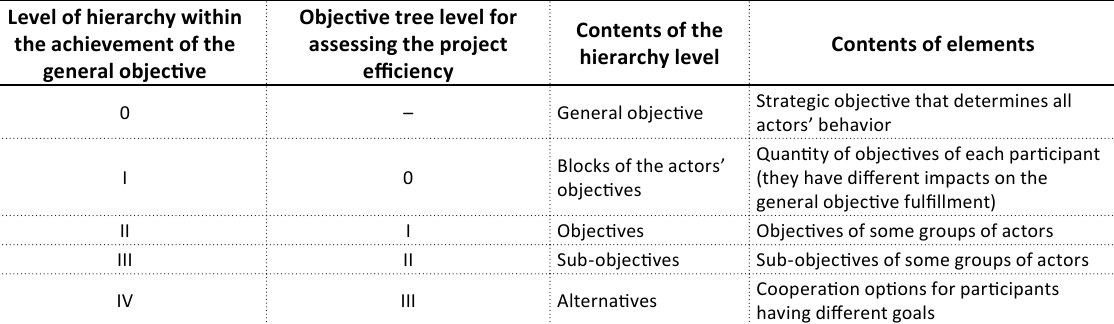
Table 1. A fragment of structuring the objectives of the multisubjuct NTS management actors by the level of their